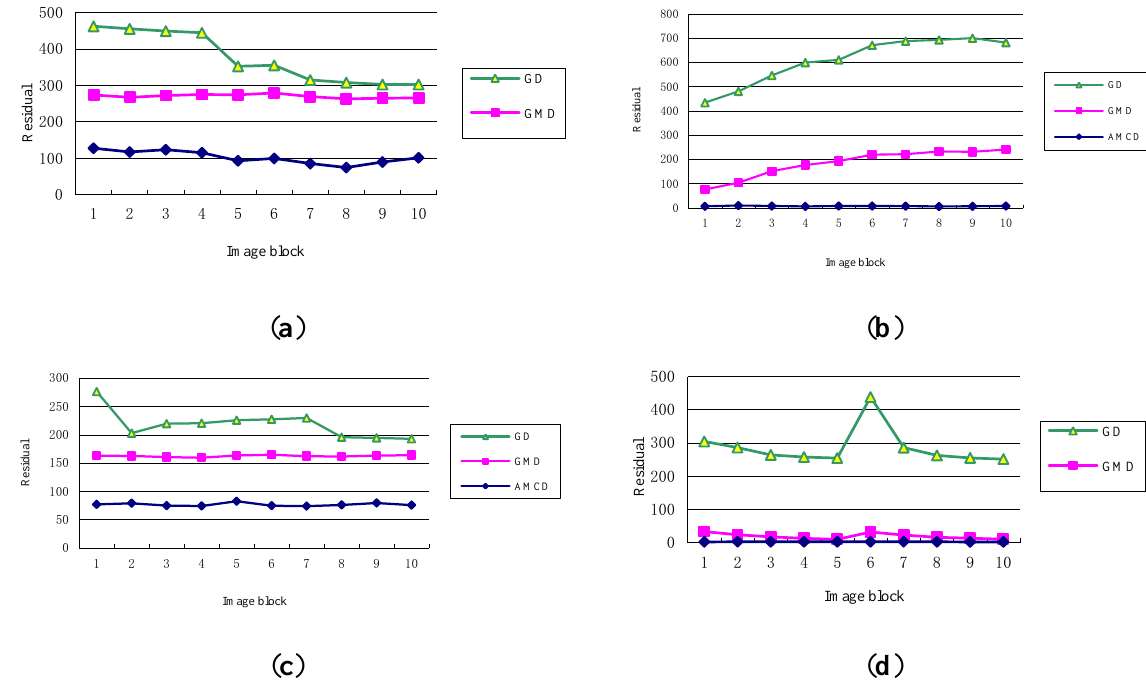
Figure 9. Residual energy after image reconstruction. ( a ) and ( b ) are target blocks in space image and cloud image, respectively. ( c ) and ( d ) are background blocks in space image and cloud image, respectively.